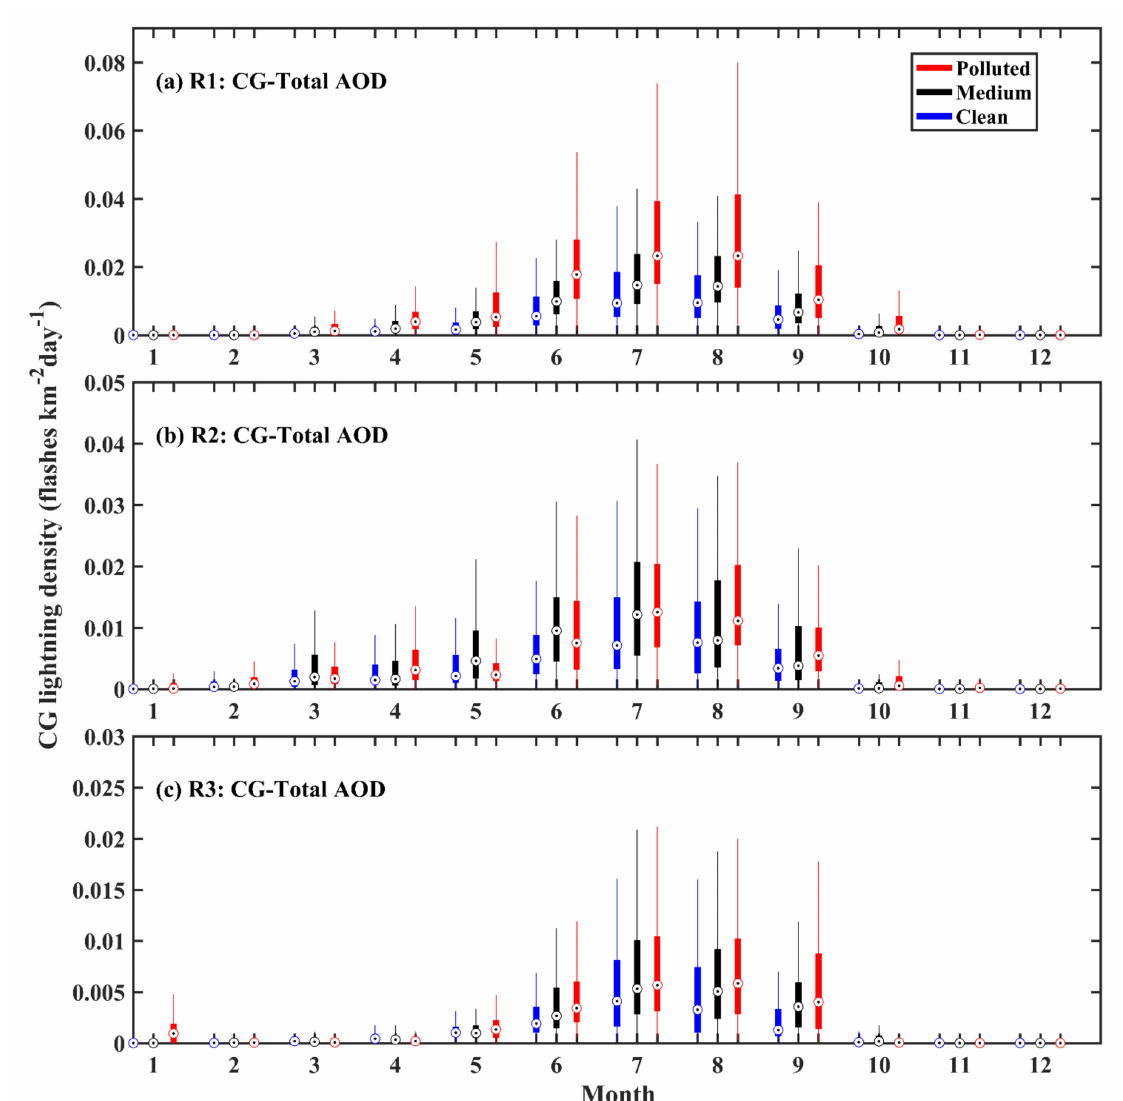
Figure 5. Box plots of CG lightning density (unit: flashes km − 2 day − 1 ) dispersion showing the values of CG lightning density under relatively clean (blue), medium (black), and polluted (red) conditions in each month over ( a ) R1, ( b ) R2, and ( c ) R3 during 2010–2018. The distance between the bottom and the top of the box represents the 25th to 75th percentile of the data in this box. The white circle in each box represents the median. The end of the whisker above and the end of the whisker below represent the maximum and the minimum, respectively. The relatively clean, medium, and polluted are defined according to the values of total AOD. All AOD data are derived from